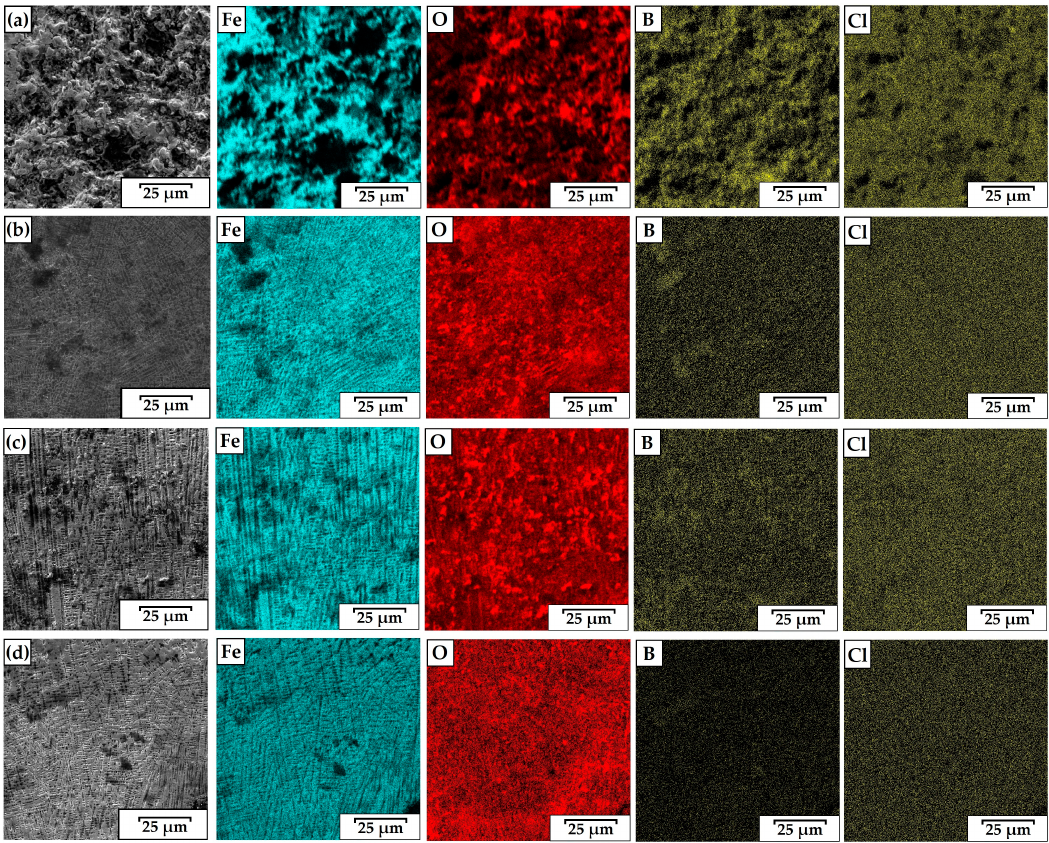
Figure 7. EDS surface mapping of diffusion boronized layer ( a ), and FeB-Fe 2 B-Fe 3 (B,C) layers produced by laser processing using 76 kW/cm 2 ( b ), 115 kW/cm 2 ( c ), 153 kW/cm 2 ( d ).